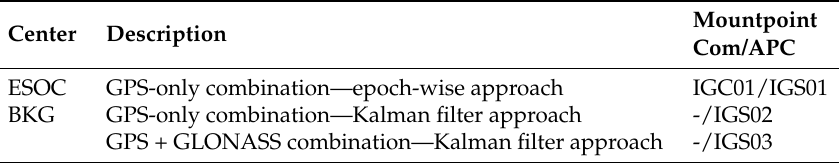
Table 2. Combined correction streams by IGS RTS Combination